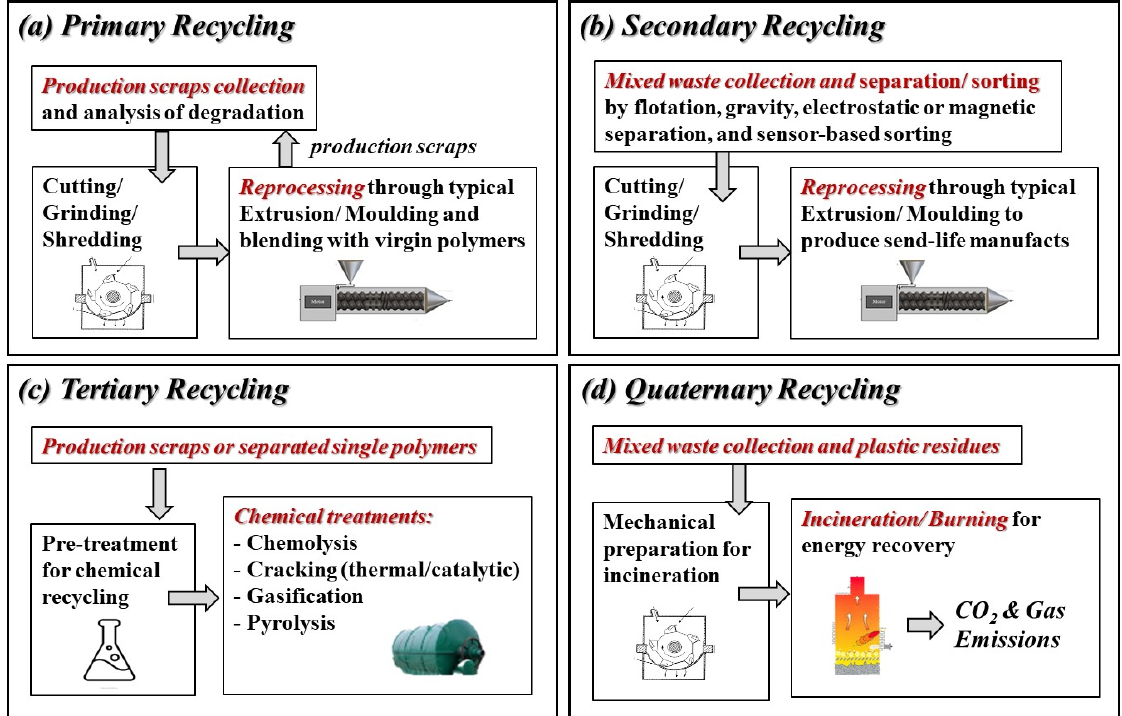
Figure 4. Overall illustrations of current strategies for the recycling of (bio)polymers and their